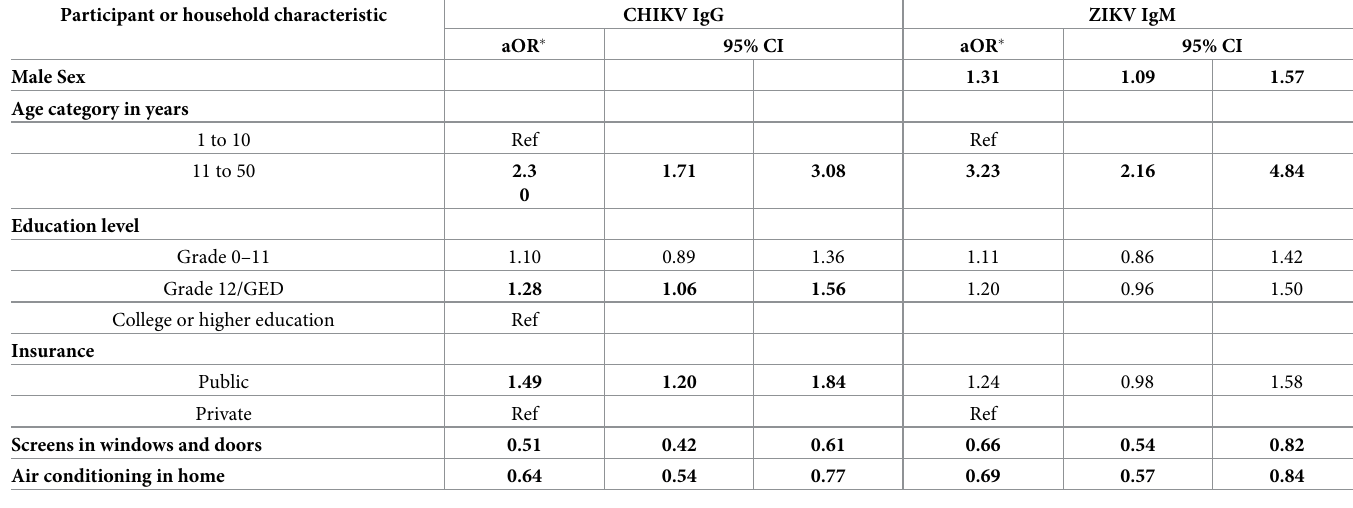
Table 2. Risk factors for previous chikungunya virus infection (IgG) or recent Zika virus infection (IgM) from the multivariate analysis. Participant or household